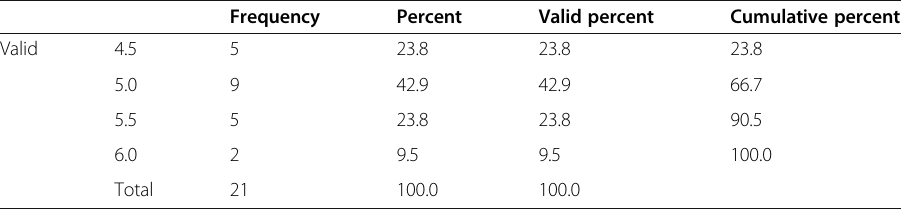
Table 2 Frequency of students ’ scores examined by trainer